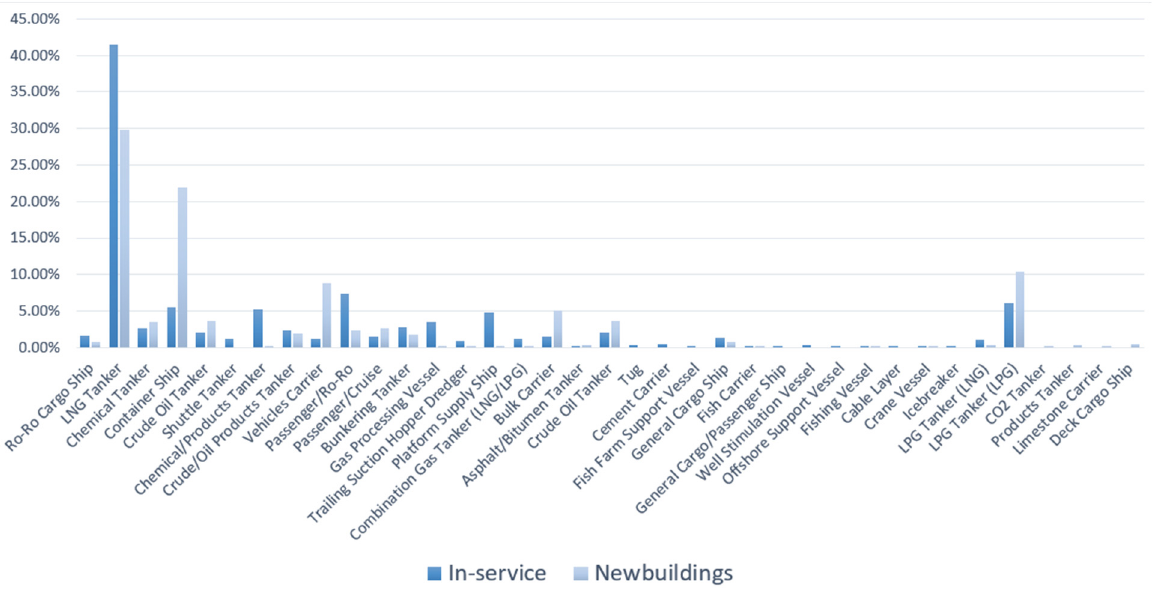
Figure 8. Vessel type for in-service and newbuildings fuelled by LNG and LPG with more than 500 DWT. Data processed from IHS Markit [56].